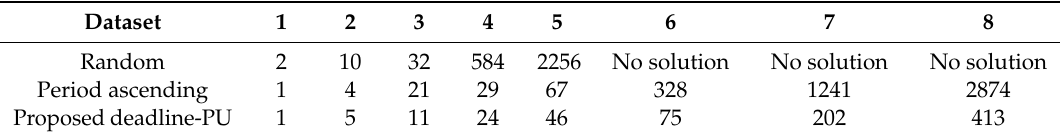
Table 6. Computation time with three ranking methods (in